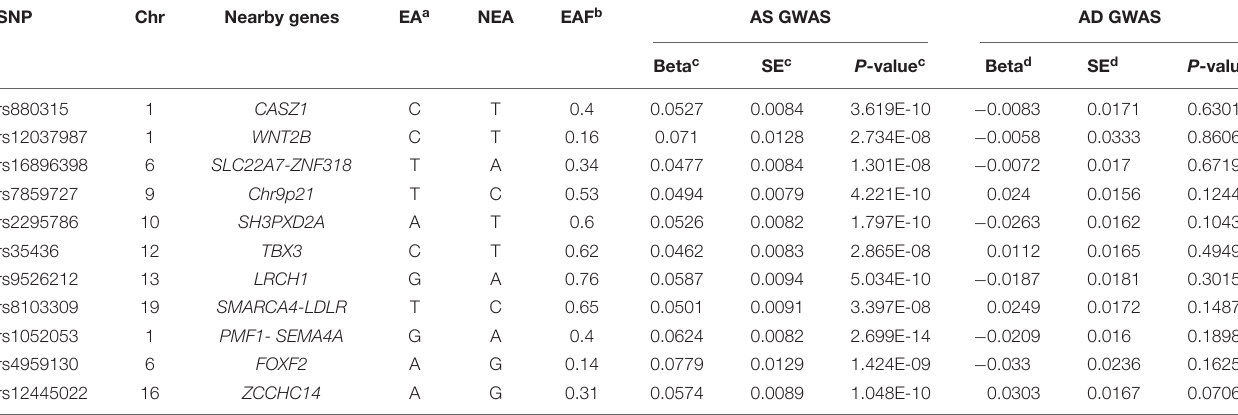
TABLE 1 | Characteristics of 11 genetic variants in AS and AD GWAS datasets.